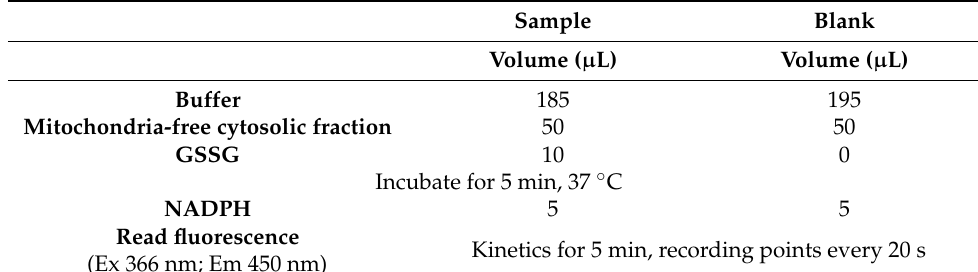
Table 2. Conditions and flow setup for GR activity